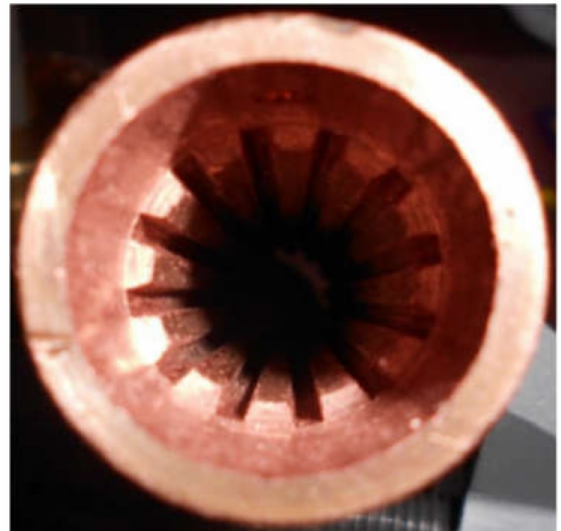
Figure 6. Cross-section of evaporator casing [20].